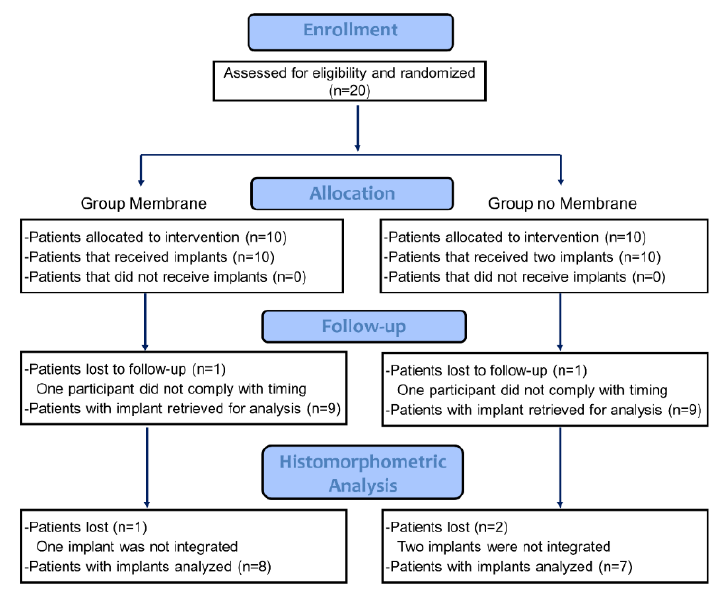
Figure 1. Consort flow diagram.